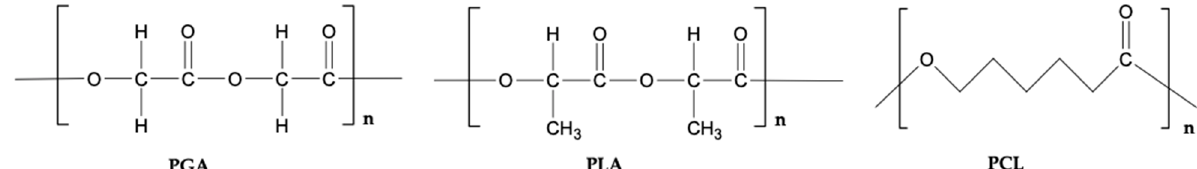
Figure 3. Chemical formulas of resorbable biodegradable polymers most commonly used in medicine: polyglycolic acid (PGA), polylactic acid (PLA) and polycaprolactone (PCL).